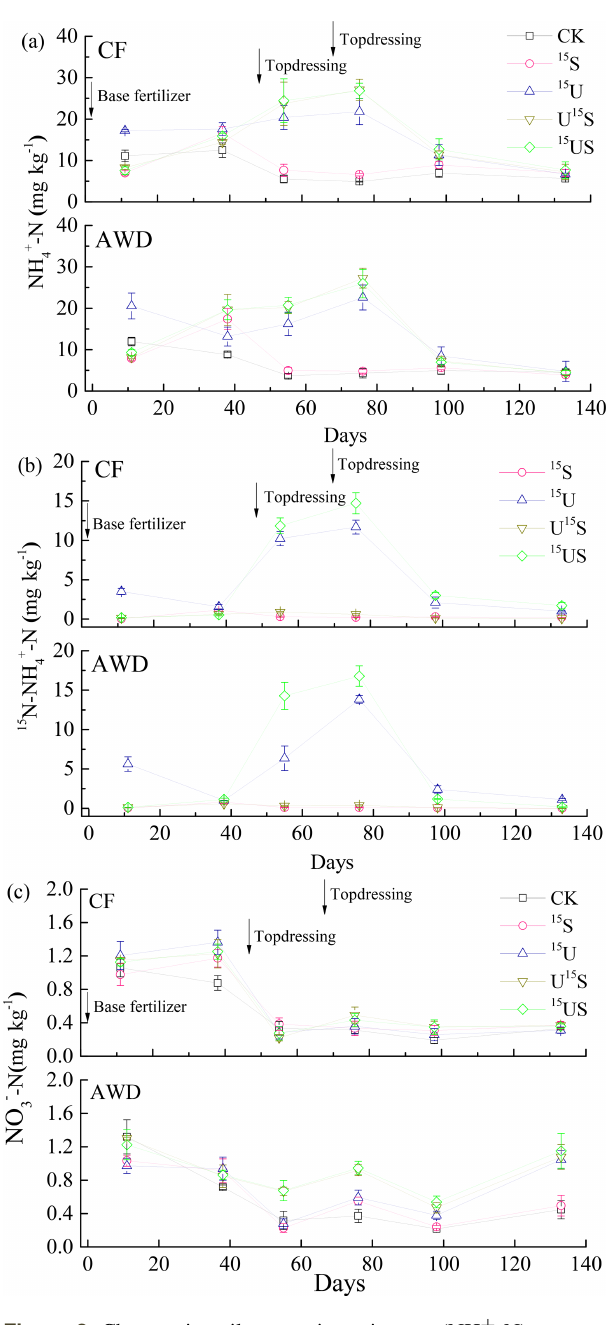
Figure 2. Changes in soil ammonium nitrogen (NH tration (a) , the contribution of 15 N markers to NH + changes in soil nitrate nitrogen (NO − the growth period of rice ( n =